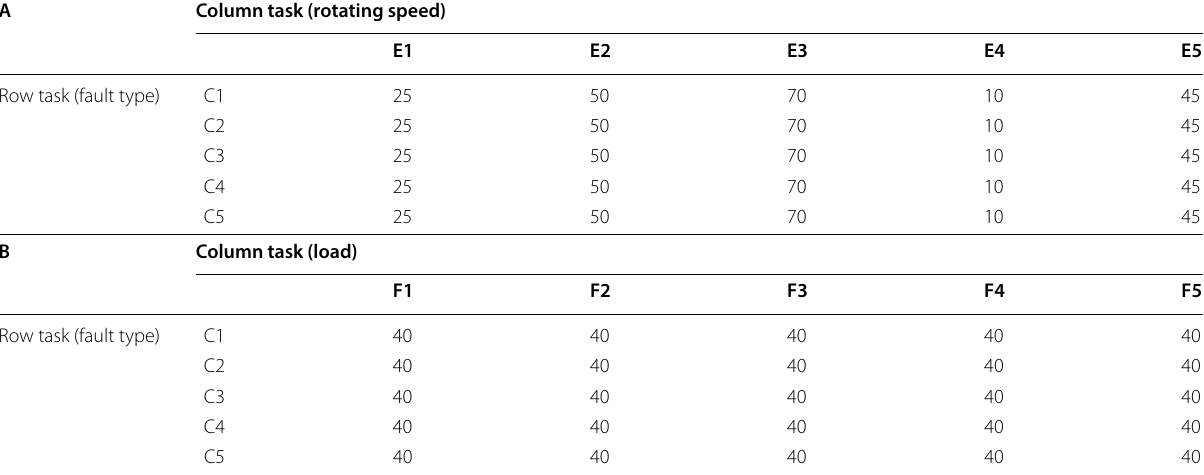
Table 4 Sample number for (A) rotating speed fault recognition and (B) load fault recognition A Column task (rotating speed)